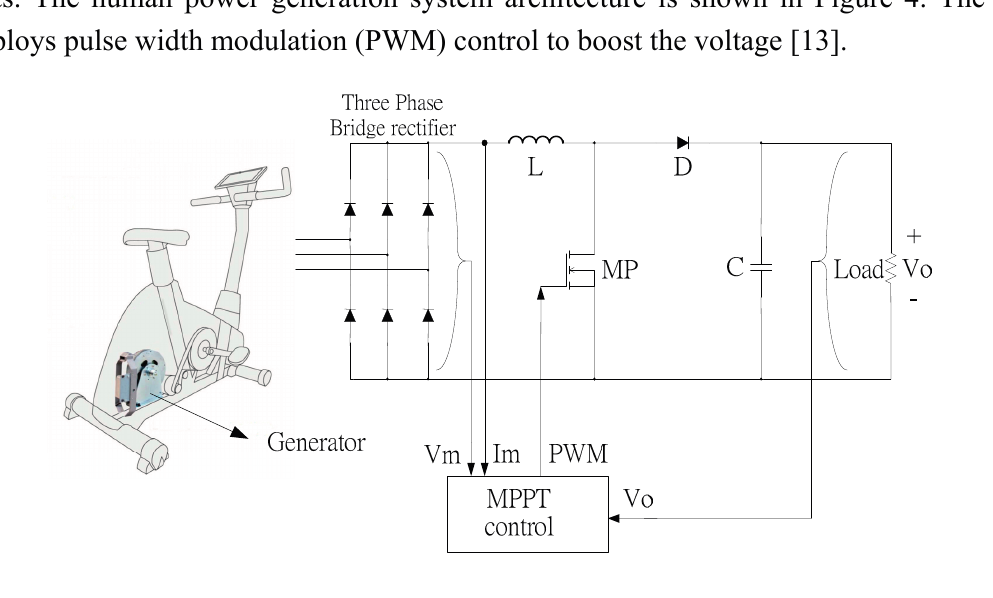
Figure 4. Human power generation system